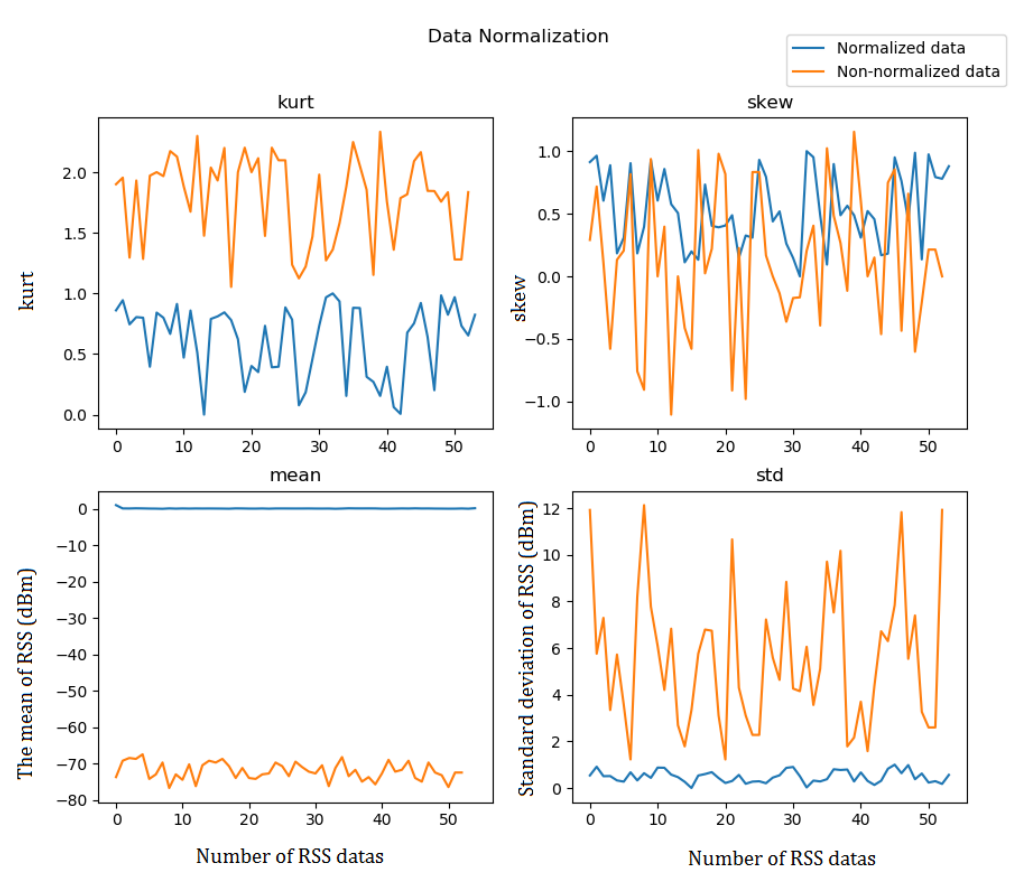
Figure 4. Normalized results of four characterizing values.